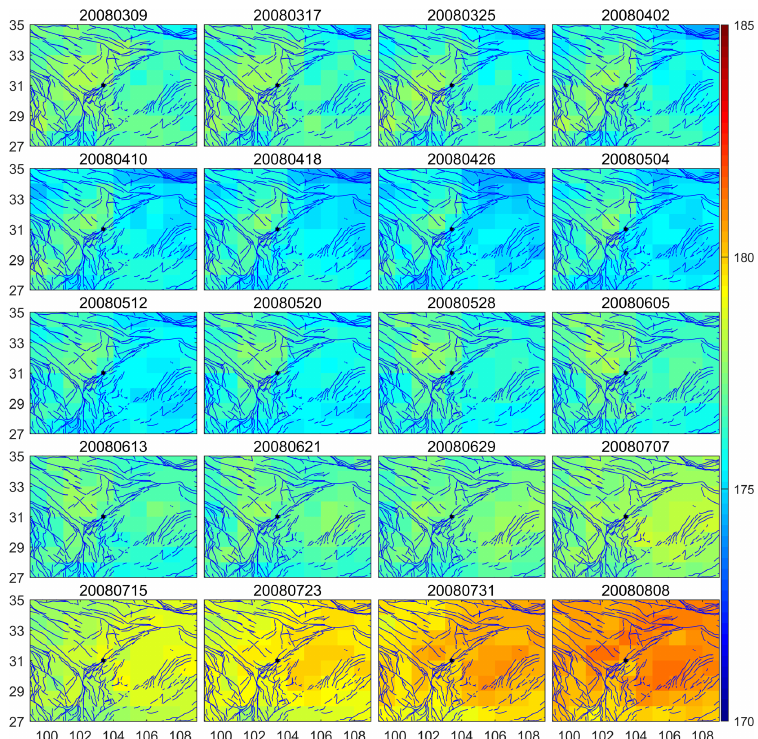
Figure 3. The 5-year (2003 to 2007) average distribution of 8d nighttime CH 4 VMR at 300hPa.